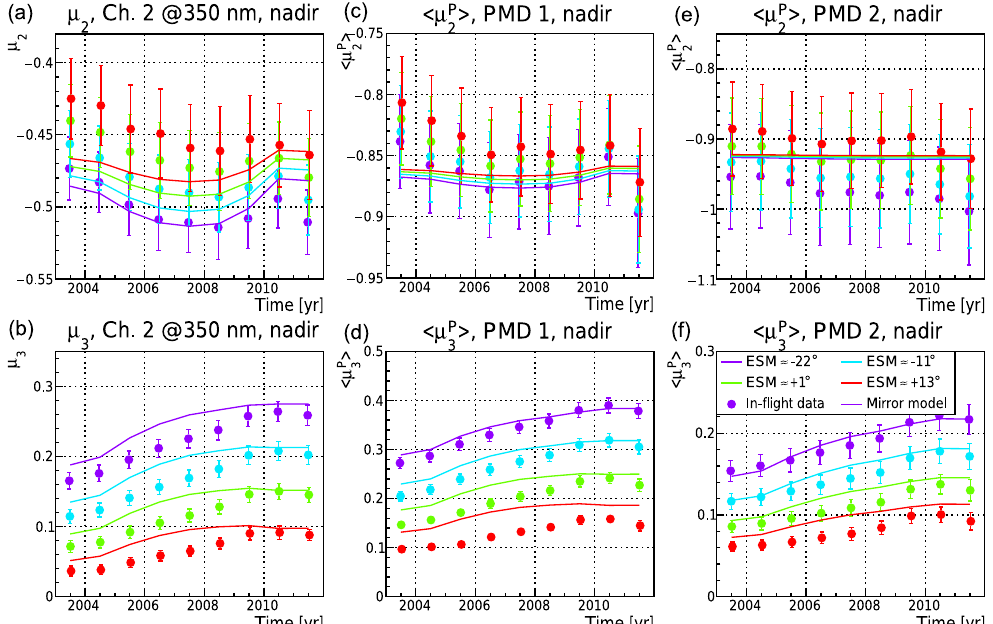
Figure 11. Time dependence of in-flight end-to-end Mueller matrix elements µ 2 (a, c, e) and µ 3 (b, d, f) for nadir for four selected ESM angles from measurements (data points) and the scan mirror model (lines). The error bars include statistical and total systematic errors. (a, b) Channel 2 feature; (c, d) PMD 1; (e, f) PMD 2. The color code signifies the ESM scan angle bin ( − 22, − 11, + 1, + 13 ◦ ), increasing on a rainbow color scale.